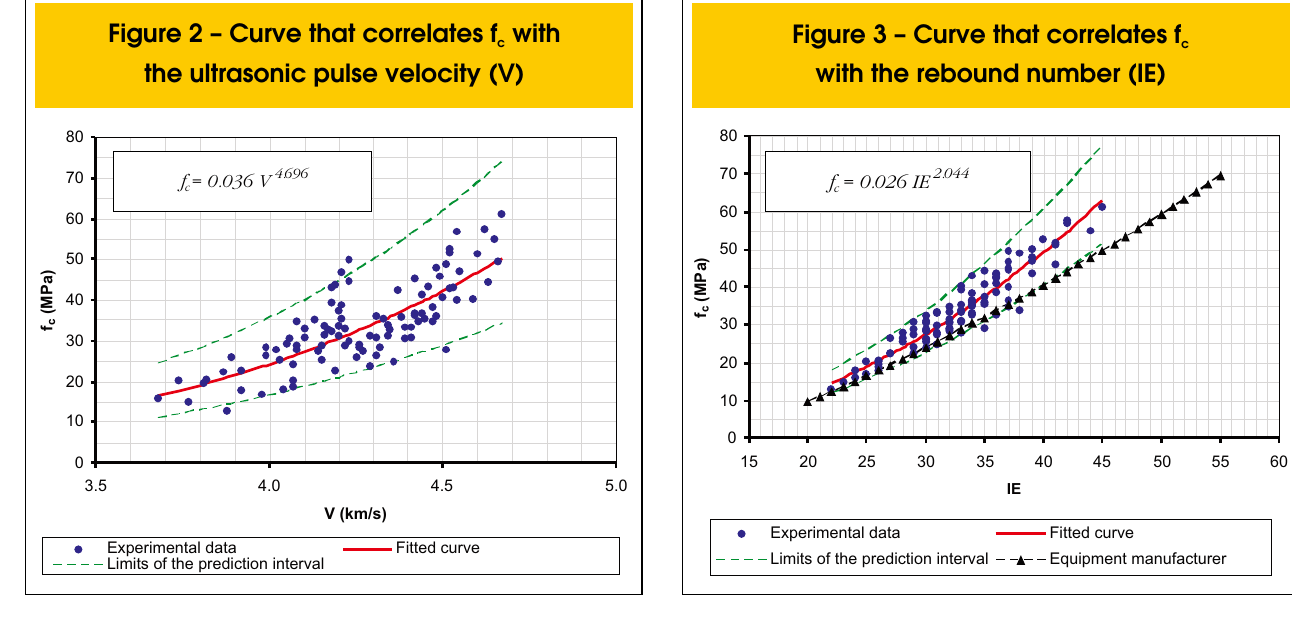
Figure 4 – Curve that correlates f with the probe penetration length (Lp)